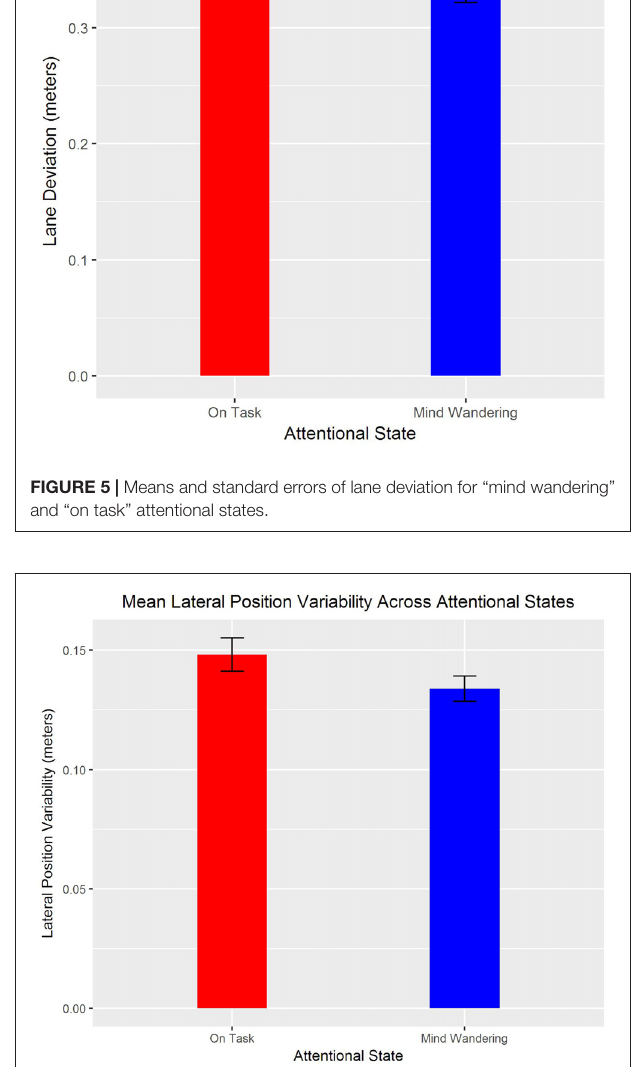
FIGURE 4 | Linear mixed model interaction between attentional state (“mind wandering”, “on task”) and days (1–5) as predictors of speed variability, p = 0.009.